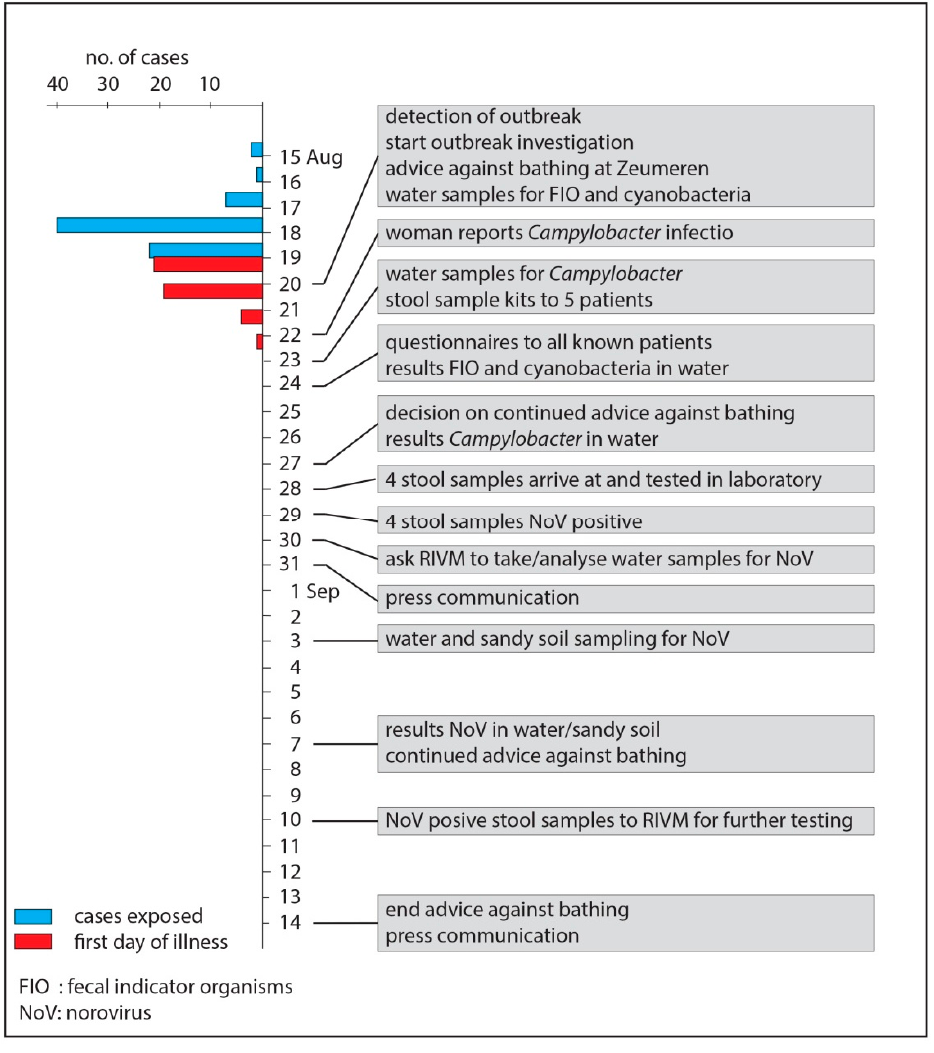
Figure 2. Epidemiological curve, indicating the days on which the cases ( n total = 45) were exposed and their first day of illness, and the timeline of the outbreak investigation.